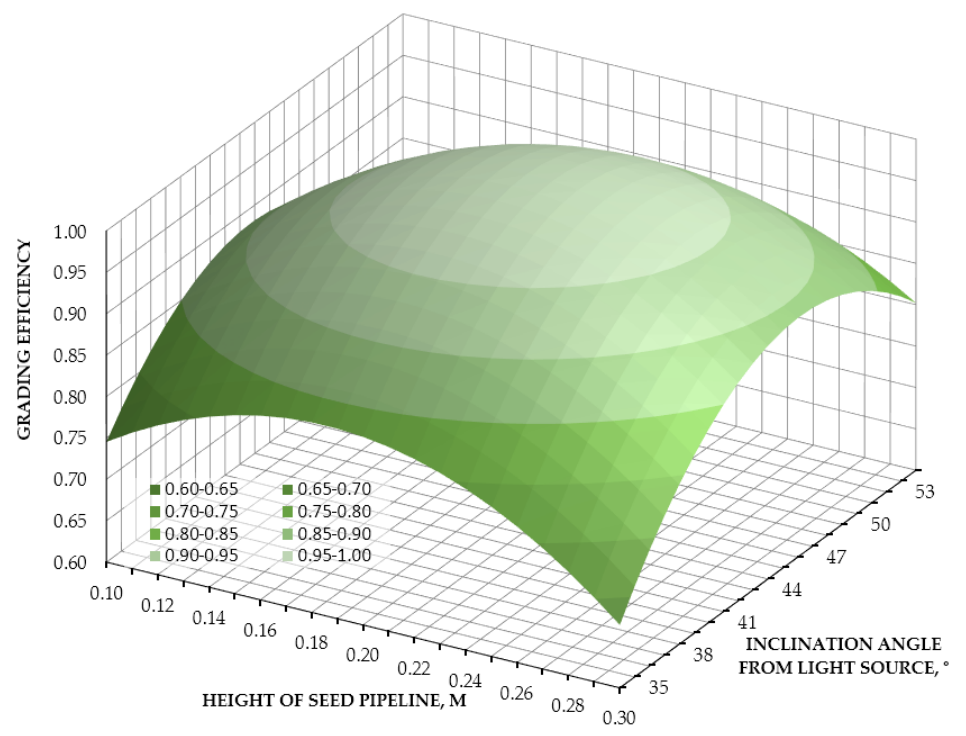
Figure 2. The response surface of the NIR grading efficiency determines the grader’s optimal engineering parameters when fixing the 970 nm level for the NIR wavelength.